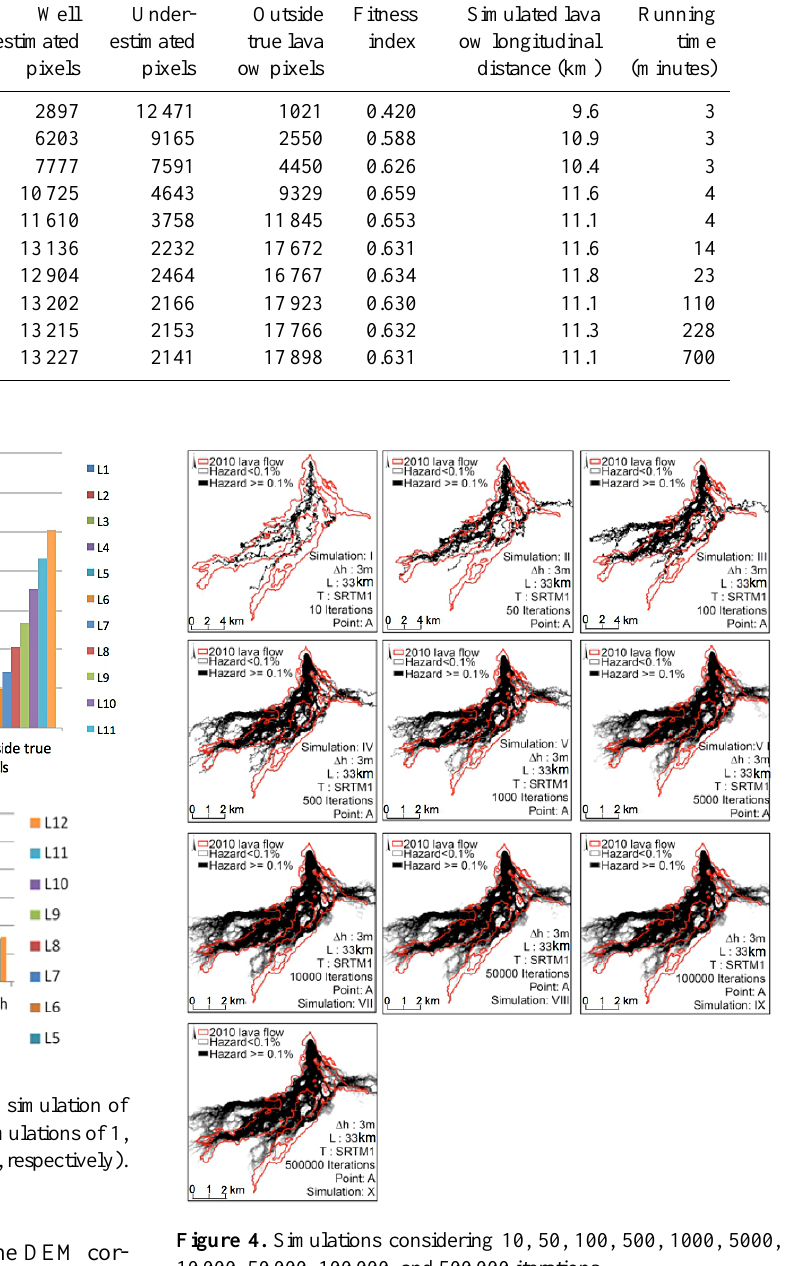
2. “Simulated pixels”: number of pixels of the DEM cor- responding to the surface covered by the simulated lava flow; 3. “Well-estimated pixels”: number of pixels of the DEM corresponding to probable pixels that coincide with true pixels; 4. “Underestimated pixels”: number of pixels of the DEM corresponding to true pixels that were not covered by probable pixels;